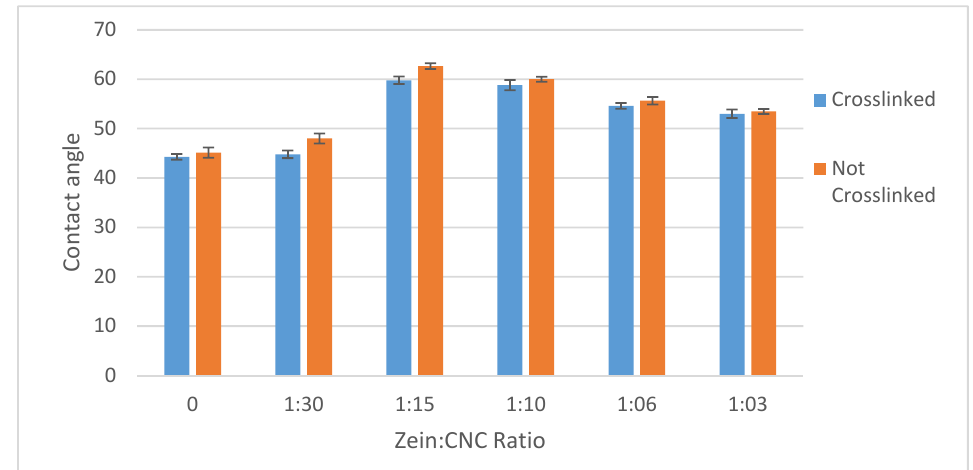
Figure 6. Films water contact angle as affected by different CNC/CZ ratio and crosslinking.